Question: Give a one-sentence summary of this figure.
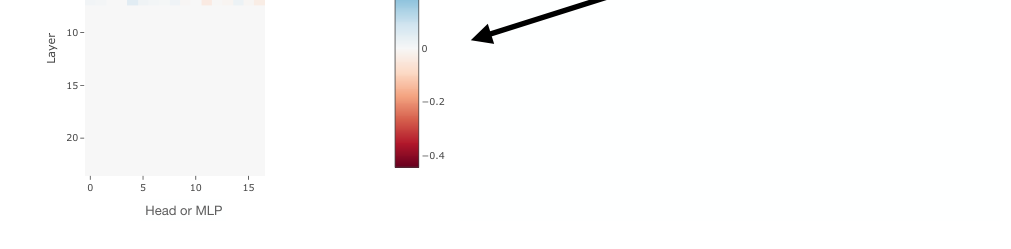
Answer: Heatmaps from path patching results from reverse engineering the Greater Than task from (Hanna et al., 2023) on GPT2-Medium. The rightmost column represent the MLPs in each layer.